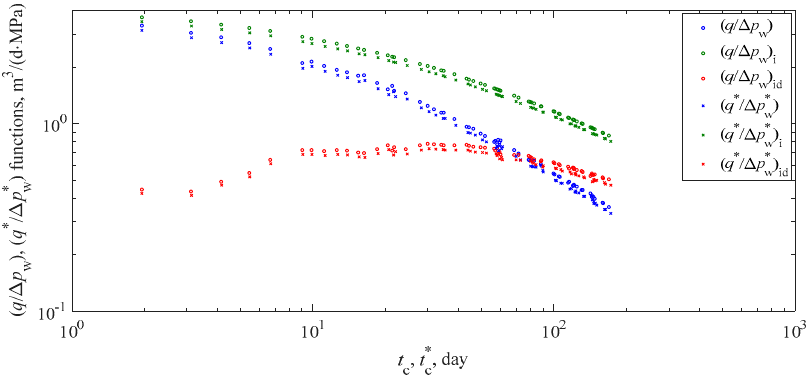
Figure 29. Normalized rate functions and modified normalized rate functions for Well XHa.